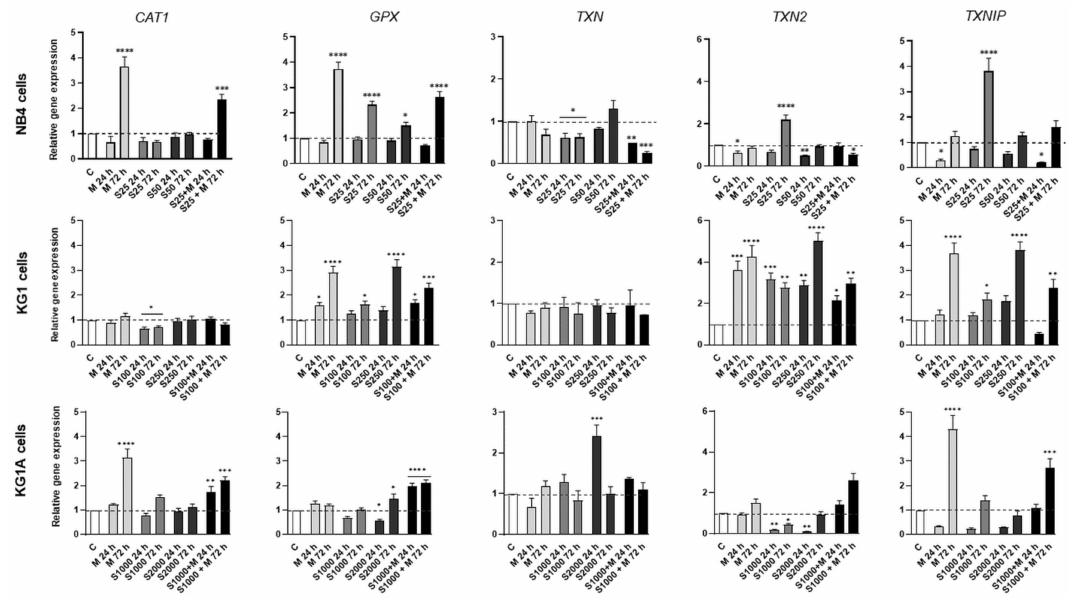
Figure 4. Metformin and MCL-1 inhibitor S63845 induced changes in the expression of antioxidant system genes. NB4 cells were treated with 25 nM and 50 nM S63845, 10 mM metformin and combination of 25 nM S63845 + 10 mM metformin. KG1 cells were treated with 100 nM and 250 nM S63845, 10 mM metformin and combination of 100 nM S63845 + 10 mM metformin. KG1A cells were treated with 1000 nM and 2000 nM S63845, 10 mM metformin and combination of 1000 nM S63845 + 10 mM metformin. Gene expression changes of antioxidant system genes CAT1 , GPX , TXN , TXN 2 and TXNIP after 24 and 72 h of treatment were measured using RT-qPCR ∆∆ Ct method. HPRT1 gene expression was used for normalization; results are presented as relative changes in comparison to untreated cells; results are mean ± S.D. ( n = 3). Note: * denotes significant difference between treated vs. control cells with p < 0.05, ** denotes significant difference with p < 0.01, *** denotes significant difference with p < 0.005 and **** denotes significant difference with p < 0.0001, as evaluated using 1-way ANOVA with Dunnett post hoc